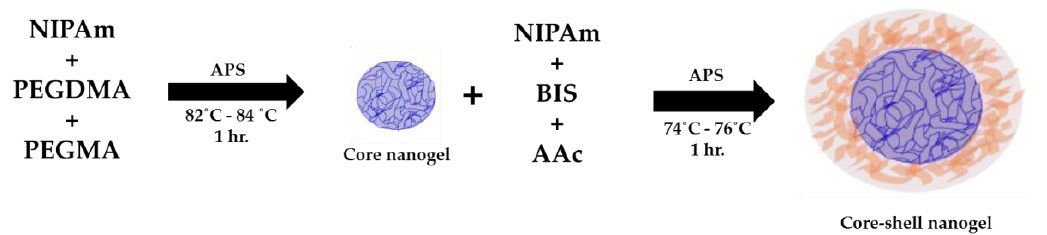
Figure 1. Schematic showing the synthesis of p [NIPAm- co -PEGMA]/p[NIPAm-co-AAc] core-shell nanogels. BIS, N , N ′ -methylenebis(acrylamide); AAc, acrylic acid.